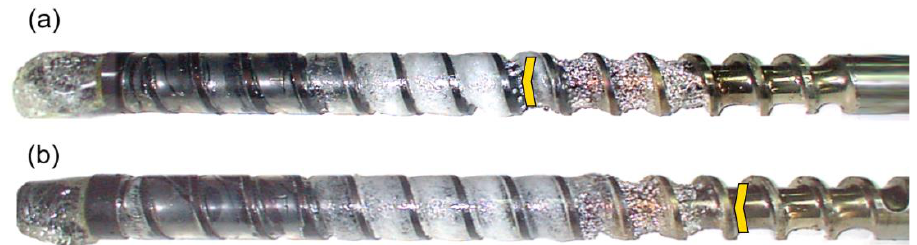
Figure 10. An effect of the screw speed on the polymer flow in the injection molding process at the plastication stroke h plast = 3 D, and the back pressure P back = 3 MPa: ( a ) N = 100 rpm, ( b ) N = 300 rpm. An effect of the plastication stroke (h plast = 1 D, h plast = 3 D) on the polymer flow in the injection molding process at the constant screw speed and the constant back pressure is